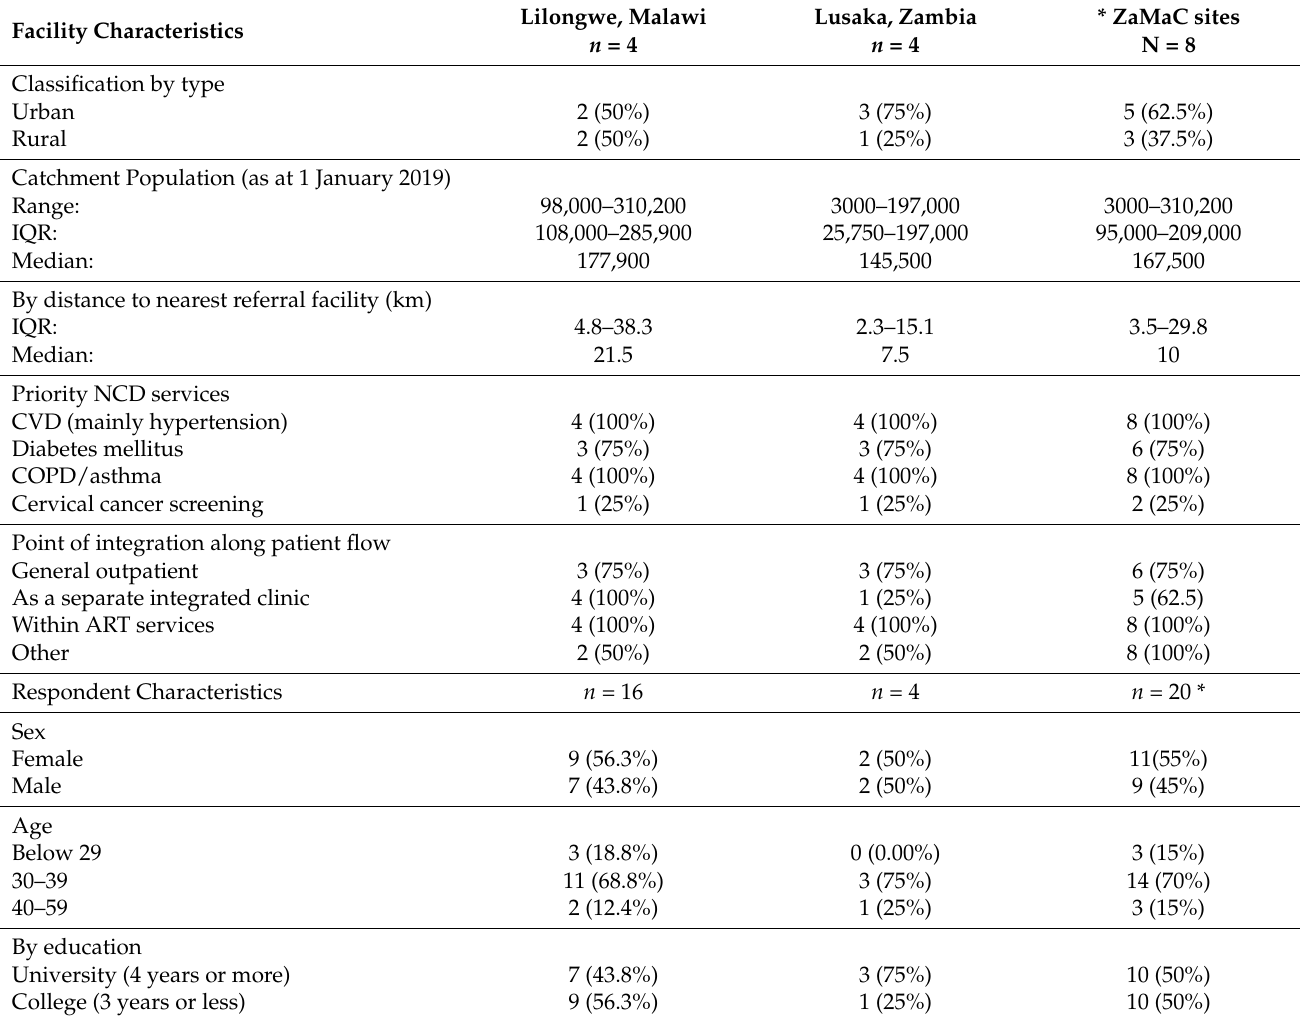
Table 1. Characteristics of Assessed PHC network sites and respondents.